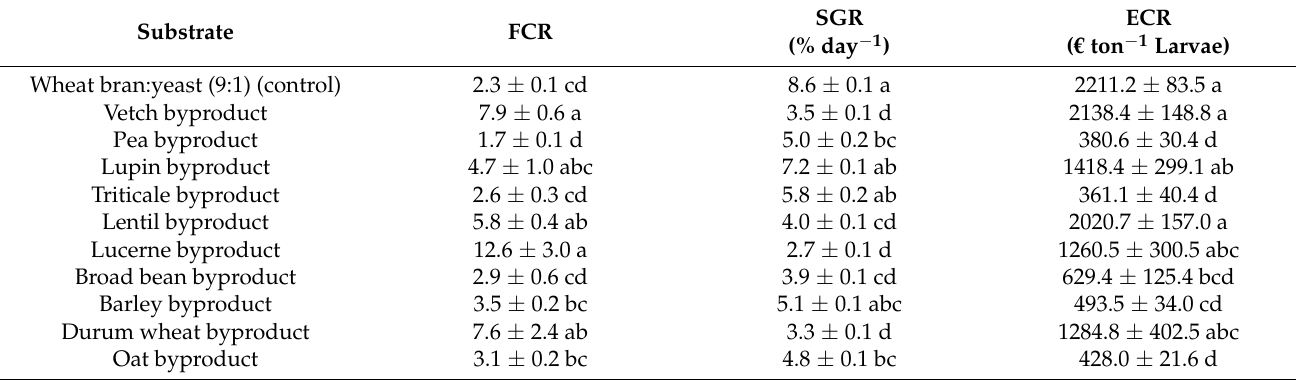
Figure 3. Development time (days) of Tenebrio molitor larvae reared on byproducts of the seed cleaning process of cereals and legumes or a mixture of wheat bran and yeast (9:1) (control). Bars followed by the same lowercase letter are not significantly different. In all cases, values represent means ± SEM (n = 6; df = 10; p = 0.05). Table 2. Feed conversion ratio (FCR), specific growth rate (SGR, % day − 1 ) and economic conversion ratio (ECR, € ton − 1 larvae) of Tenebrio molitor larvae reared on byproducts of the seed cleaning process of cereals and legumes and a mixture of wheat bran and yeast (9:1) (control) (n = 6).